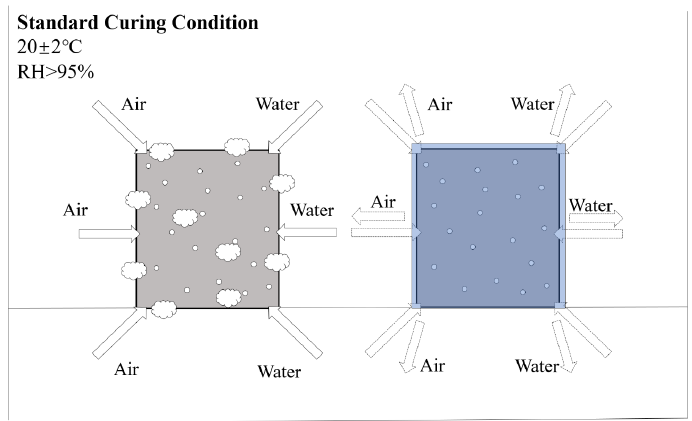
Figure 3. The positive effect on efflorescence is caused by overlay curing (20 ± 2°C, RH > 95%).